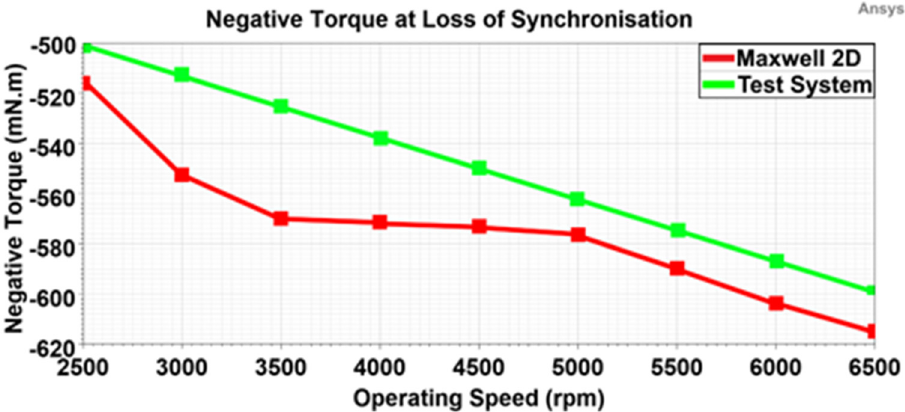
Figure 16. Negative torque at loss of synchronisation depending on operating speed.